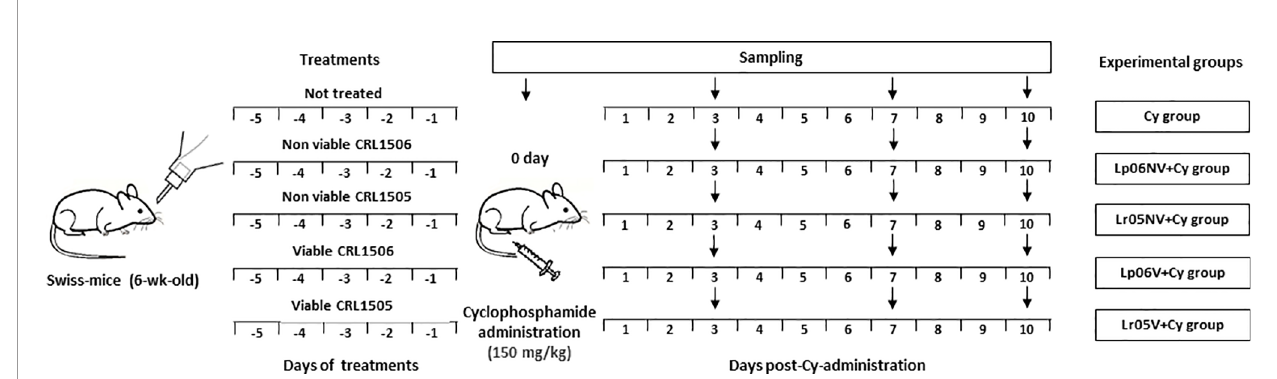
FIGURE 1 | Schematic representation of the feeding protocols used in this study. Treatment of mice by feeding with viable or non-viable L. rhamnosus CRL1505 (Lr05V+Cy or Lr05NV+Cy groups) or L. plantarum CRL1506 (Lp06V+Cy or Lp06NV+Cy groups) for 5 consecutive days before injection of Cy. A control group (Cy group) were mice without probiotic treatment. Determinations were performed on day 0 (before Cy administration) and in different times after Cy administration for 10 days. The black down arrows indicate the sampling day. In the experiments 6 animals were used per group for each